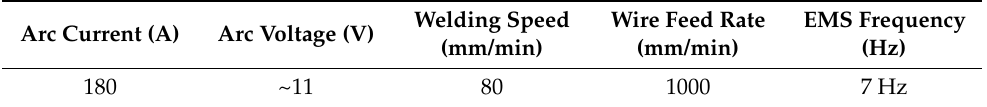
Table 2. The welding parameters.